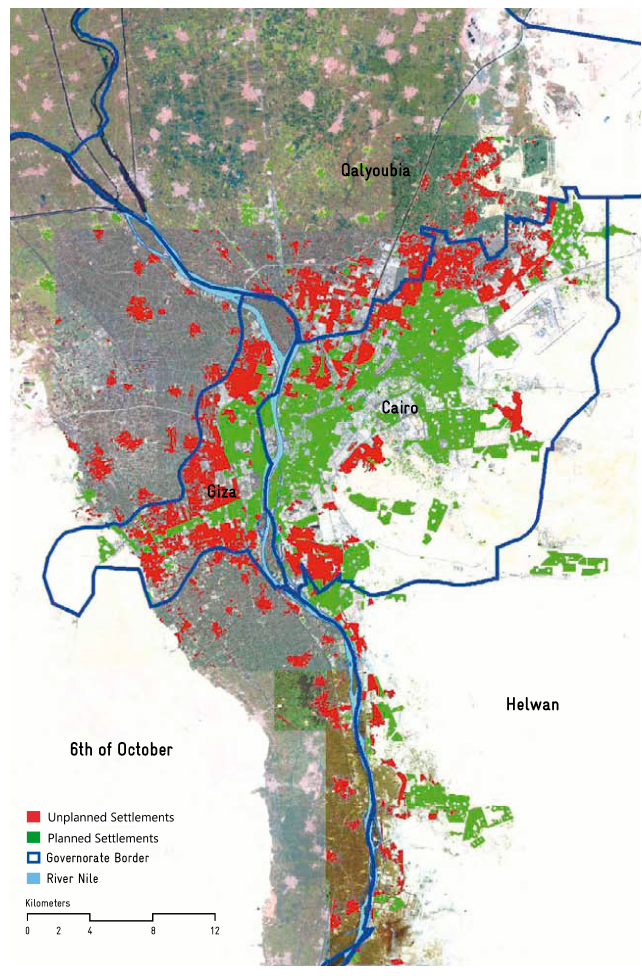
Figure 1. Unplanned settlements in GCMR, Source: Kipper & Fischer, 2009 [2] with authors modifications.